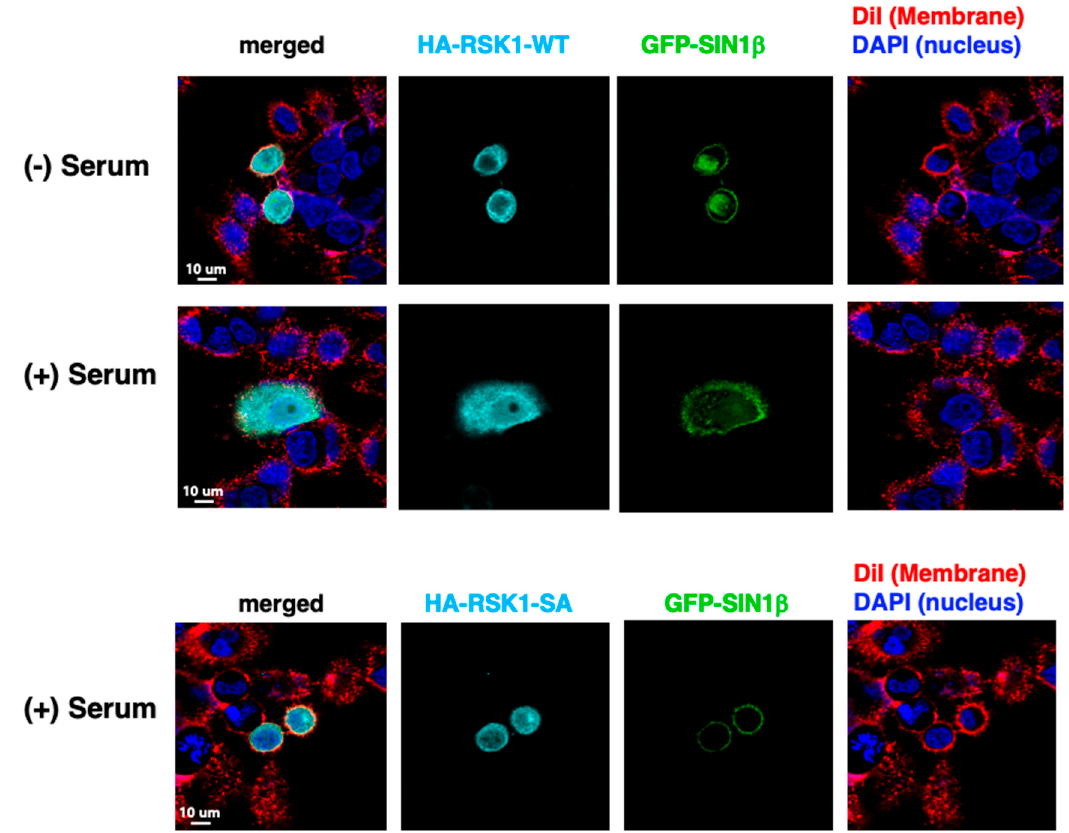
Figure 6. RSK and SIN1 colocalize at the plasma membrane. WT MEFs were co-transfected with GFP-SIN1 β and avian HA-RSK-WT or HA-RSK-SA mutant (Ser381 Ala). After 48 h, cells were restimulated with serum for 15 min. Staining and microscopy were performed to detect GFP, HA as well as DiI (membrane) and DAPI (nucleus).